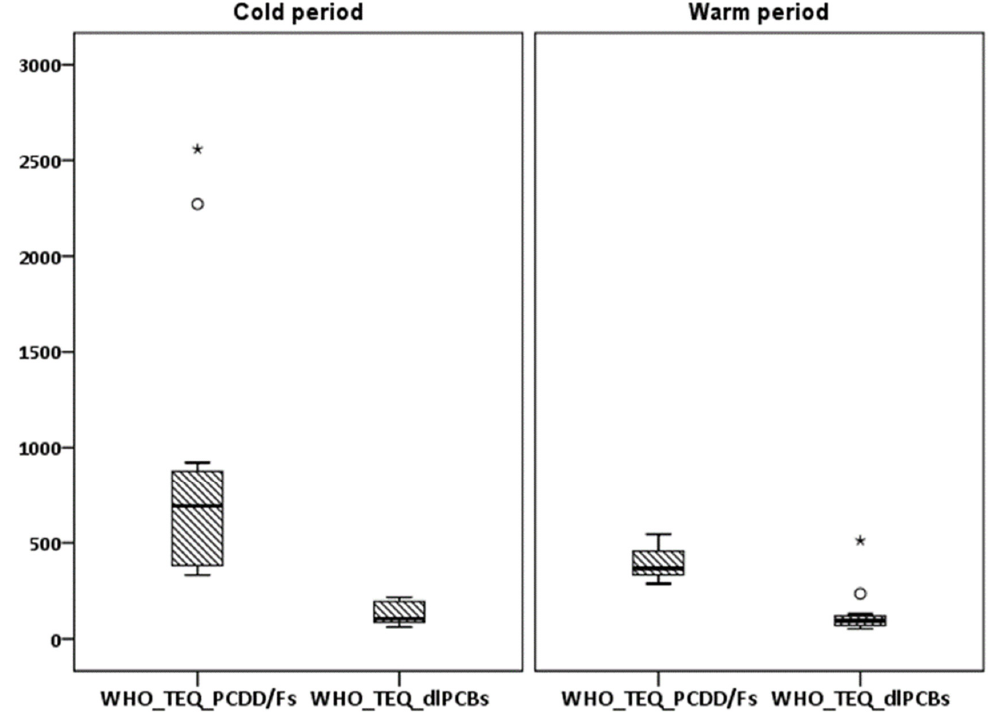
Figure 6. WHO-TEQ 2005 seasonal variations for PCDD/Fs and dlPCBs (* outliers and o values above 3rd quartile).